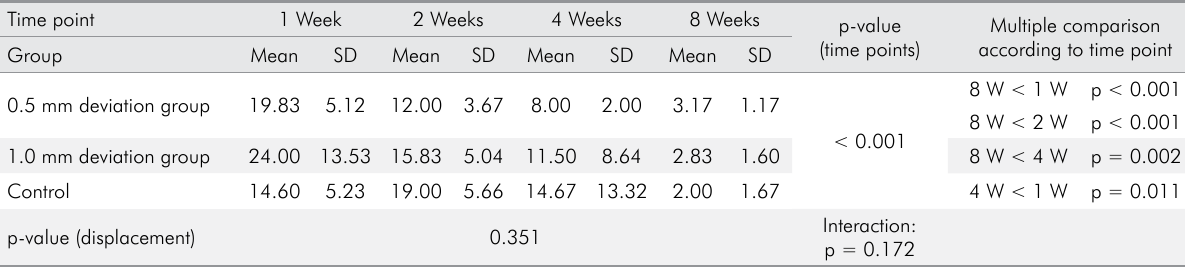
Table 2. Comparison of TRAP cell count according to time point and